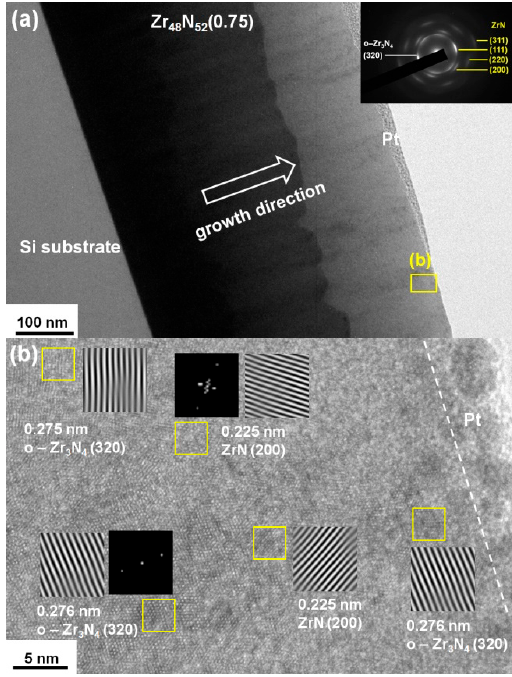
Figure 3. ( a ) Cross-sectional transmission electron microscope (TEM) image and selected area diffraction pattern (SADP), and ( b ) a high-resolution image of the Zr 48 N 52 (0.75) films.